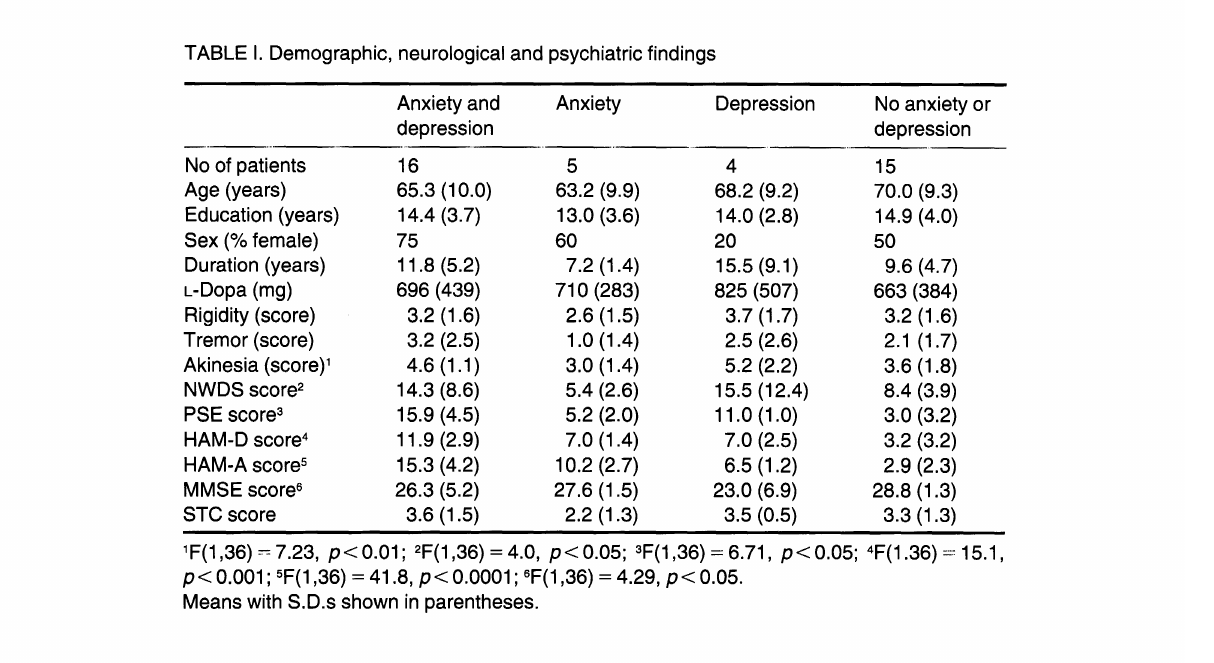
TABLE I. Demographic, neurological and psychiatric findings Anxiety and Anxiety Depression No anxiety or depression No of